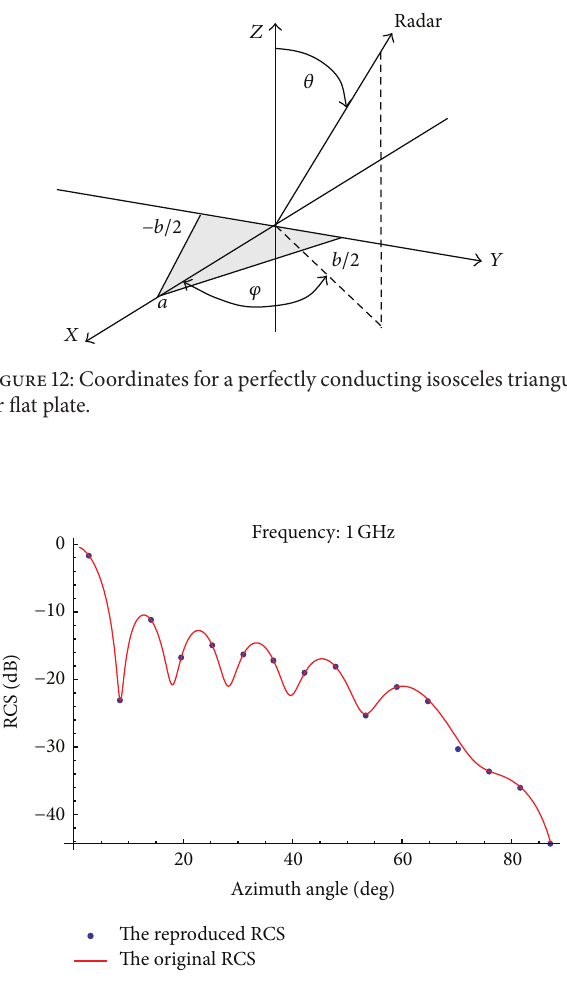
Figure 13: Backscattered RCS for a perfectly conducting triangular flat plate, 𝑘 = 4 and 𝜑 = 60 ∘ .